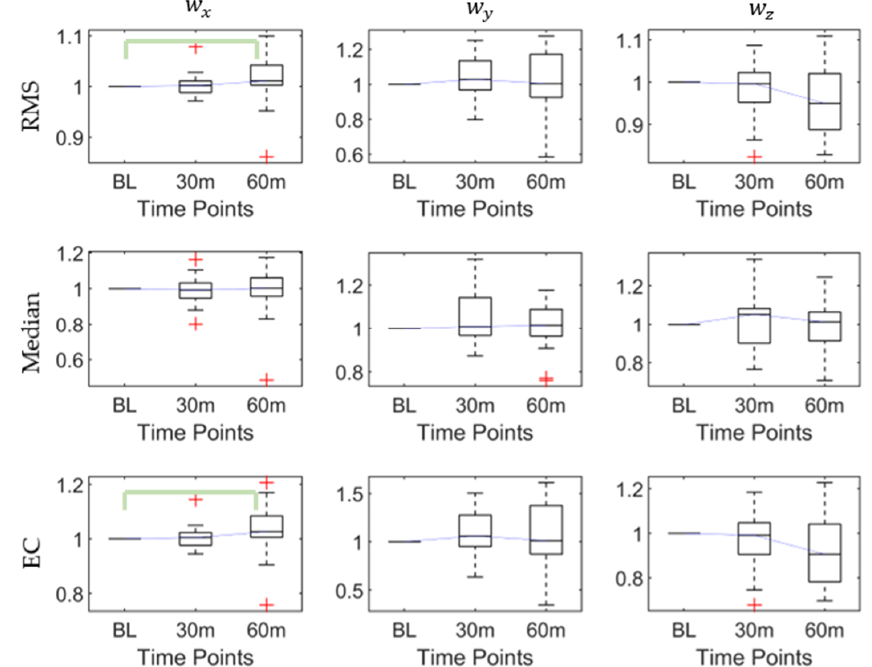
Figure 3. The root mean square (RMS), median, and energy consumption (EC) of angular velocities at baseline, 30th min, and 60th min. Bracket denotes statistical significance ( p < 0.05) in the post hoc analysis with Bonferroni correction.